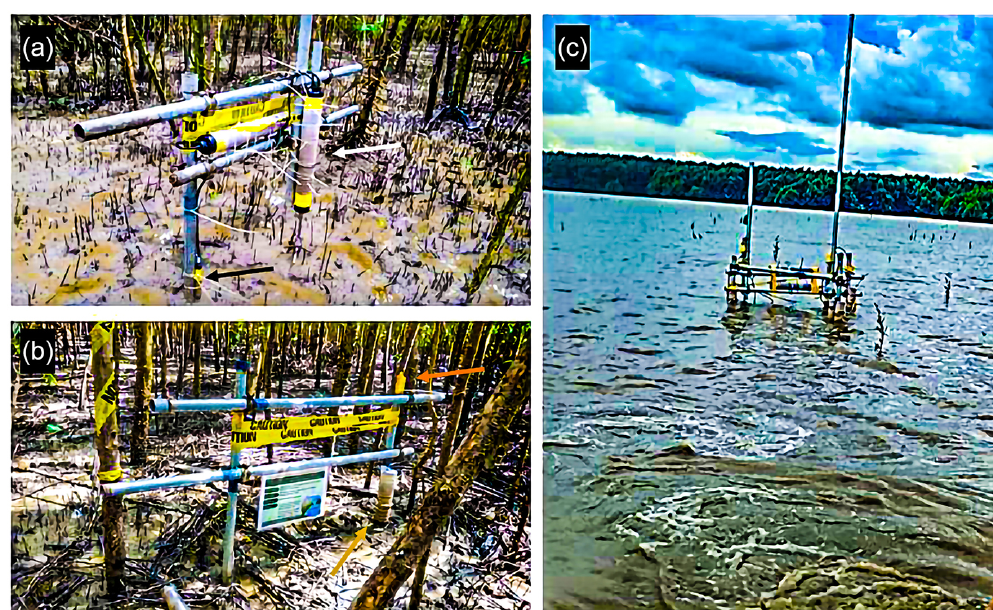
Figure 4. Simultaneous deployment of pressure transducers (gold arrows), acoustic Doppler velocimeters (white arrow), conductivity– temperature–depth loggers (orange arrow) and the optical backscatter sensors (black arrows) at the Chateau Margot transect (MB). (a) A view of station MB 3 in the sparser Avicennia -dominated forest approximately 110m away from the concrete dyke. (b) A view of station MB 1 in the denser part of the Avicennia -dominated forest approximately 30m from the concrete dyke. (c) A view of station MB 5 (located on the mudflat) used in the test deployment and field calibration of all of the